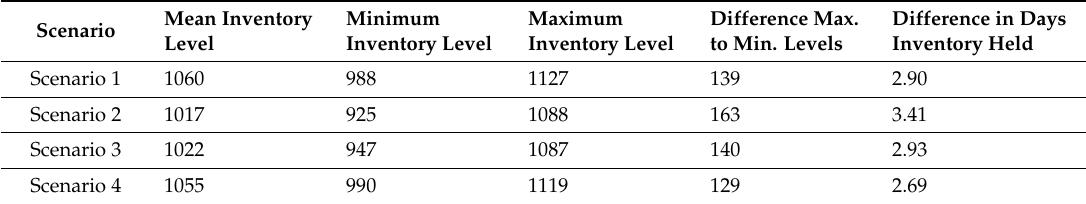
Table 8. Key parameters of inventory levels in scenarios 1–4.